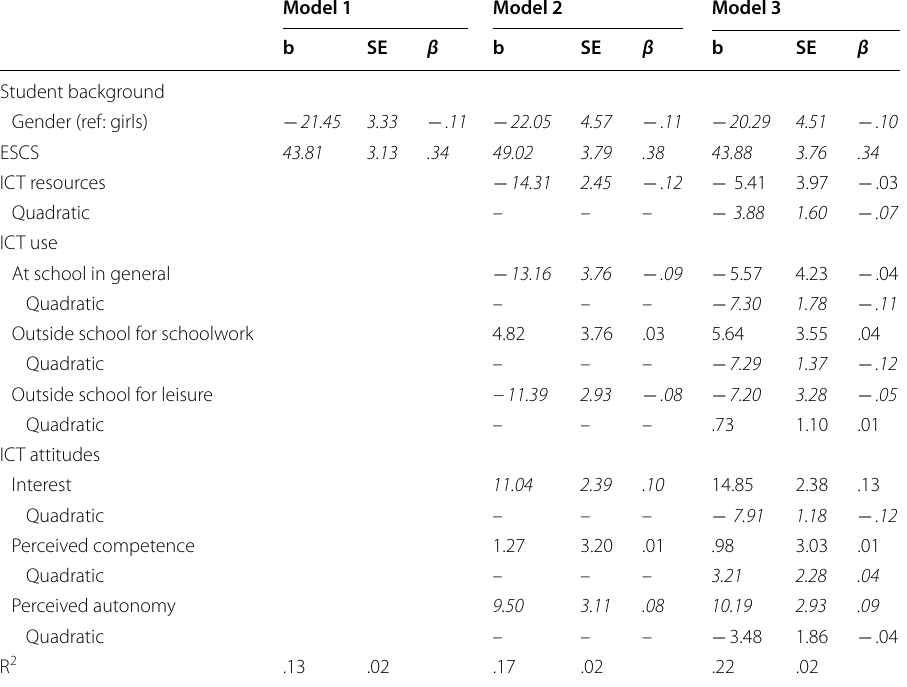
Table 4 Standardized and unstandardized effects of ICT resources, use, and attitudes on digitally assessed reading